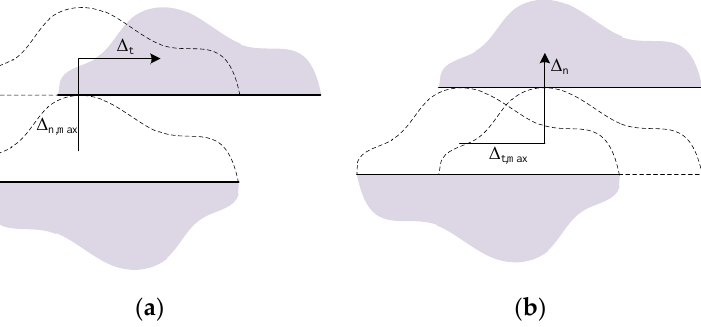
Figure 7. Two arbitrary separation paths for the debonding analysis: ( a ) non-proportional Path 1 and ( b ) non-proportional Path 2.